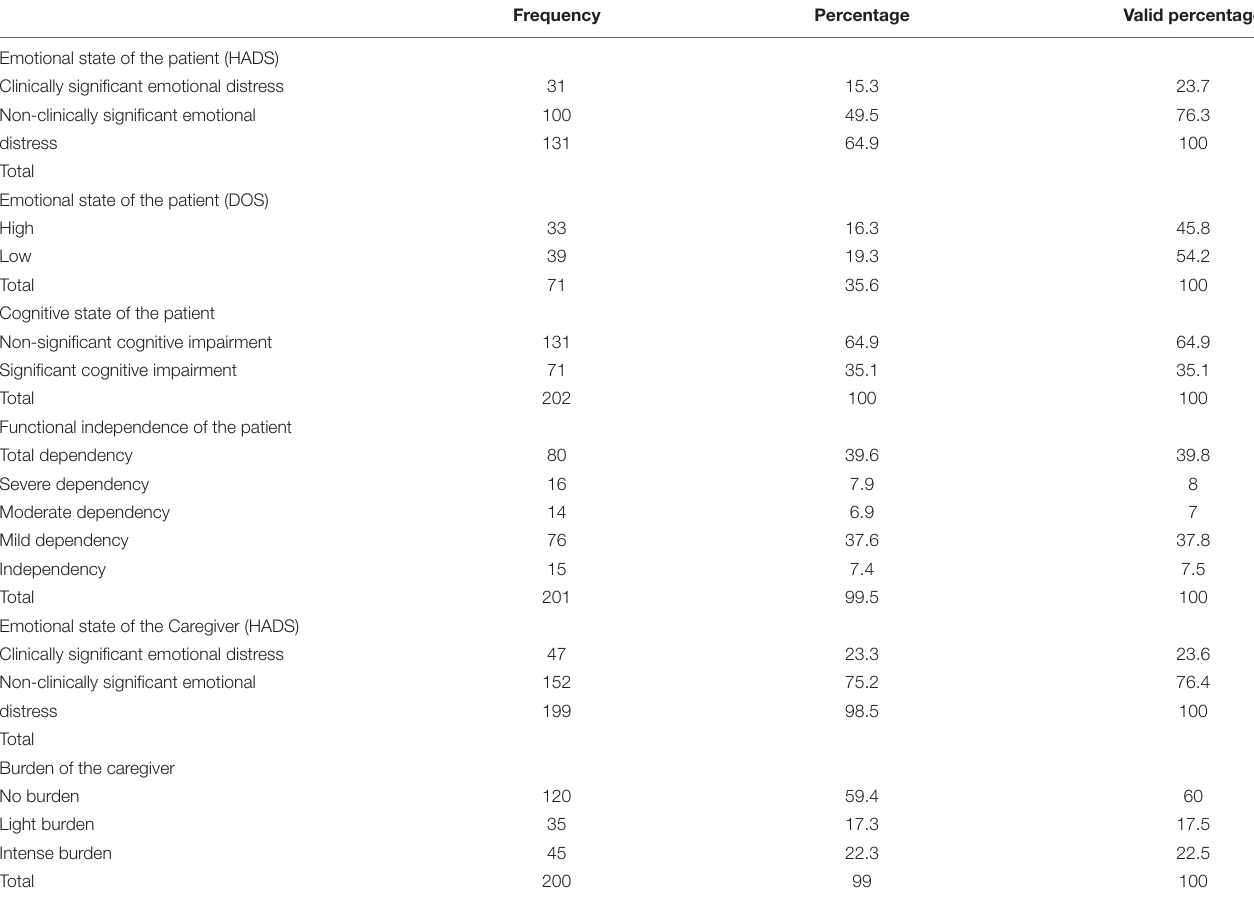
TABLE 1 | Descriptive statistics for main variables of